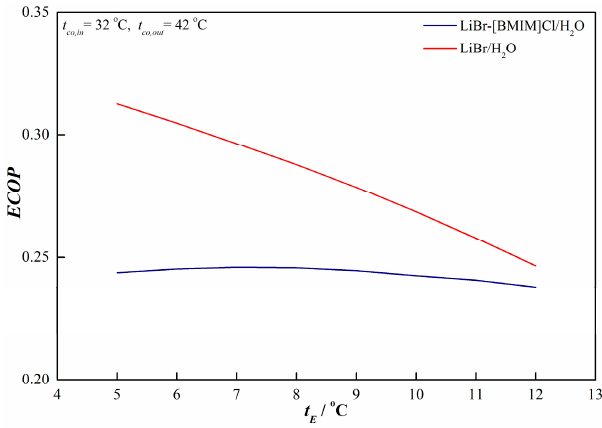
Figure 11. Variations of exergetic coefficient of performance (E COP ) with the evaporation temperature t E .